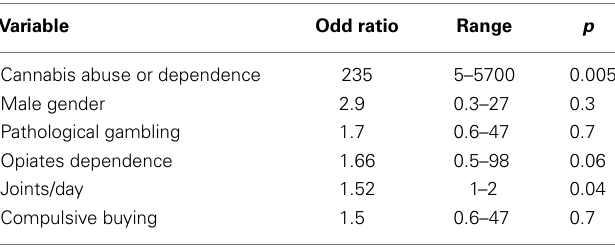
Table 5 | Logistic regression assessing factors associated to cannabis consumption